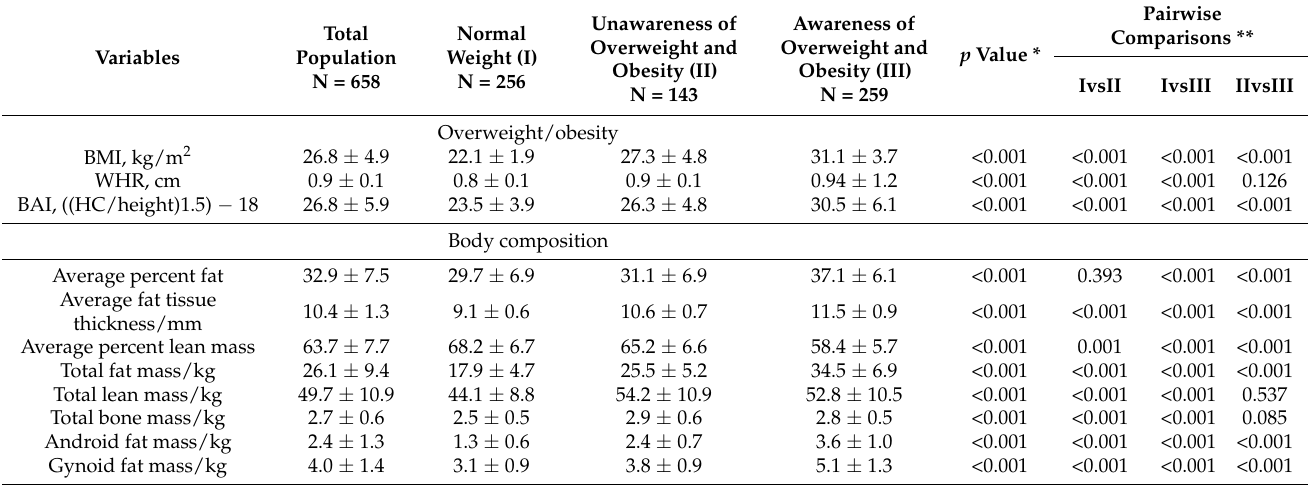
Table 3. Anthropometry and body composition of the study